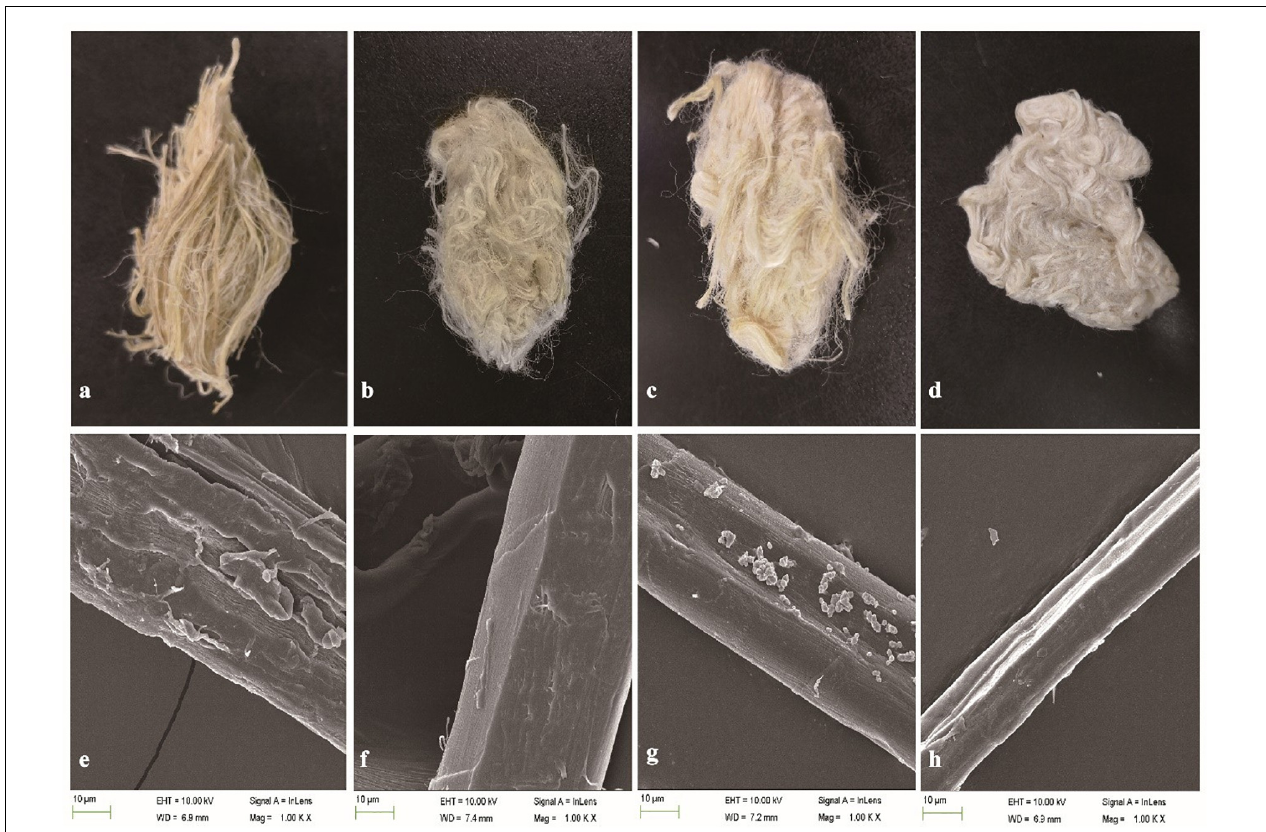
FIGURE 6 | SEM images of ramie fibers treated (a,e) : with buffer only (negative control); (b,f) : with BspPel; (c,g) : with chemicals only (positive control); and (d,h) : with the enzyme-chemical method. (a–d) : External images of ramie fibers; (e–h) : surface images of single fibers (1000 ×